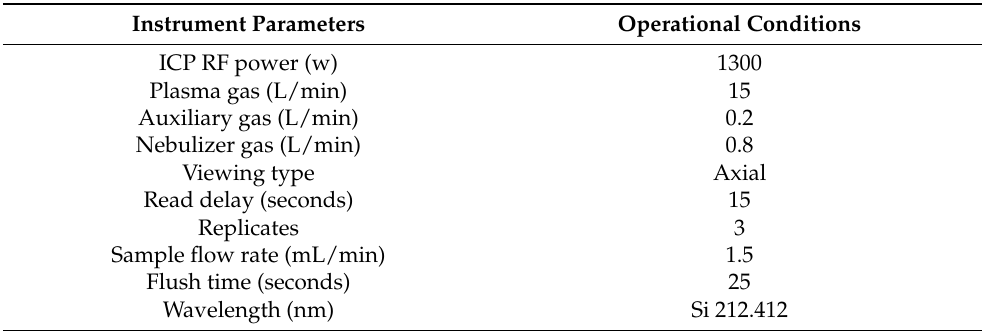
Table 1. Operational parameters of inductively coupled plasma–optical emission (ICP-OES) spec- trometer for silicon (Si) determination from E. debile